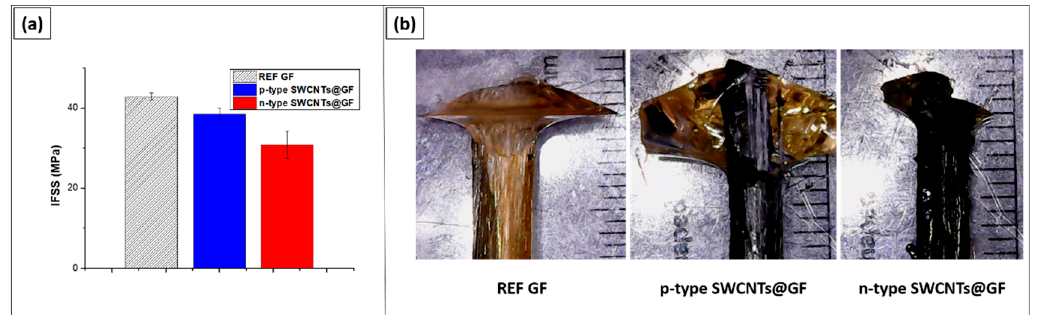
Figure 8. ( a ) Interfacial shear strength values for the p-type and the n-type TE model composites compared to the reference one, ( b ) fractography images for the respective three examined categories.